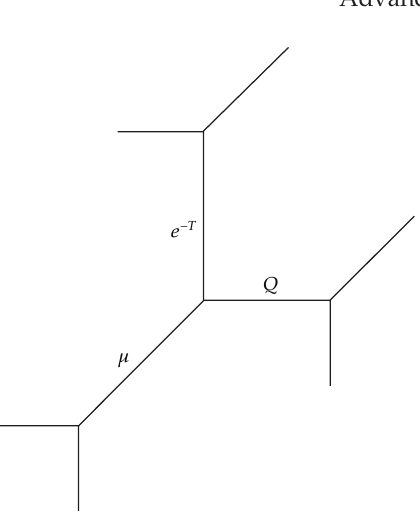
Figure 15: The spectral curve for the conifold matrix model (cid:4) 5.9 (cid:5) in arbitrary closed BPS chamber coincides with the mirror curve of the closed topological vertex geometry, whose toric diagram is shown above. This geometry has three P 1 moduli, which encode conifold size Q , the closed BPS chamber via μ , and finite ’t Hooft coupling via e − T